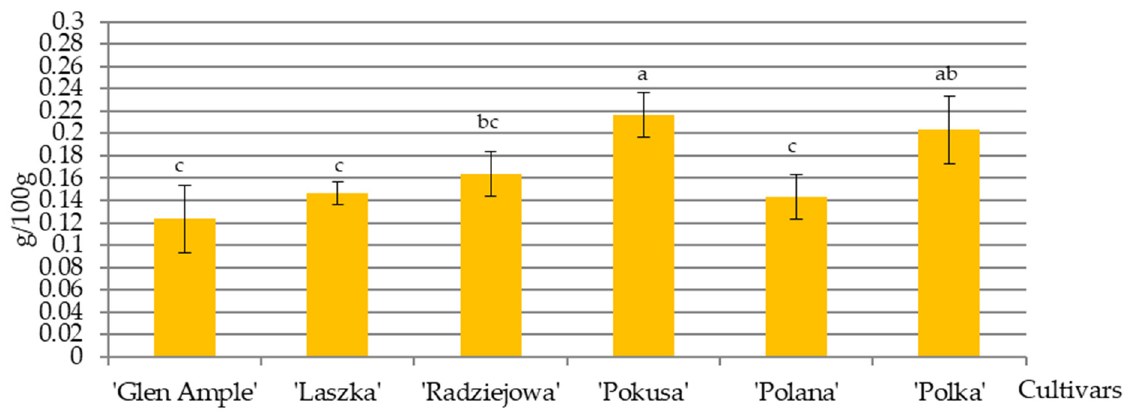
Figure 3. Total protein concentration in the nectar of the six R. idaeus cultivars analyzed in the three study years. Explanations: means followed by the same letter are not significantly between the cultivars at a significance level α = 0.05 (one-way ANOVA, Tukey’s test).